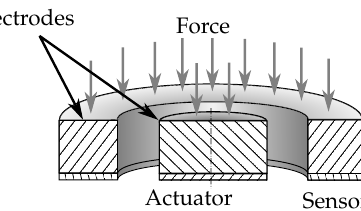
Figure 2. Alternative sensor design for more robust resonant ultrasonic cure monitoring